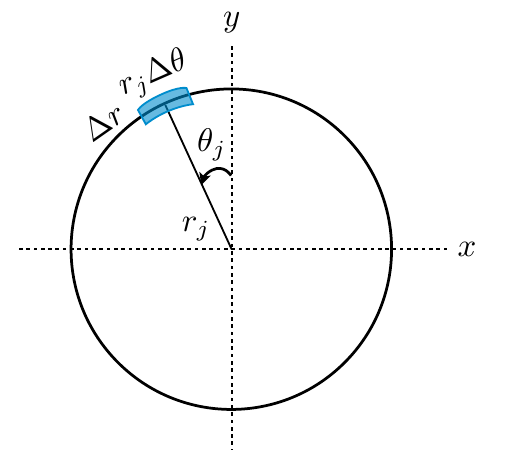
Figure 7. In-plane area for volume force at a given azimuthal sta-